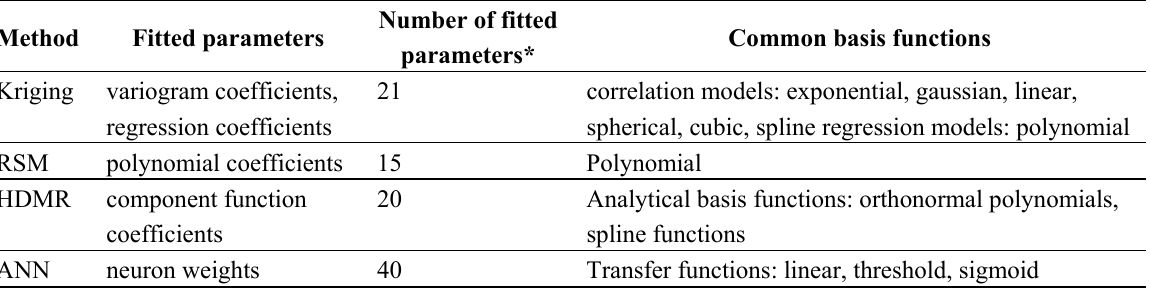
Table 3. Comparison of reduced order modeling methodologies, Kriging, response surface models, high dimensional model representation and artificial neural